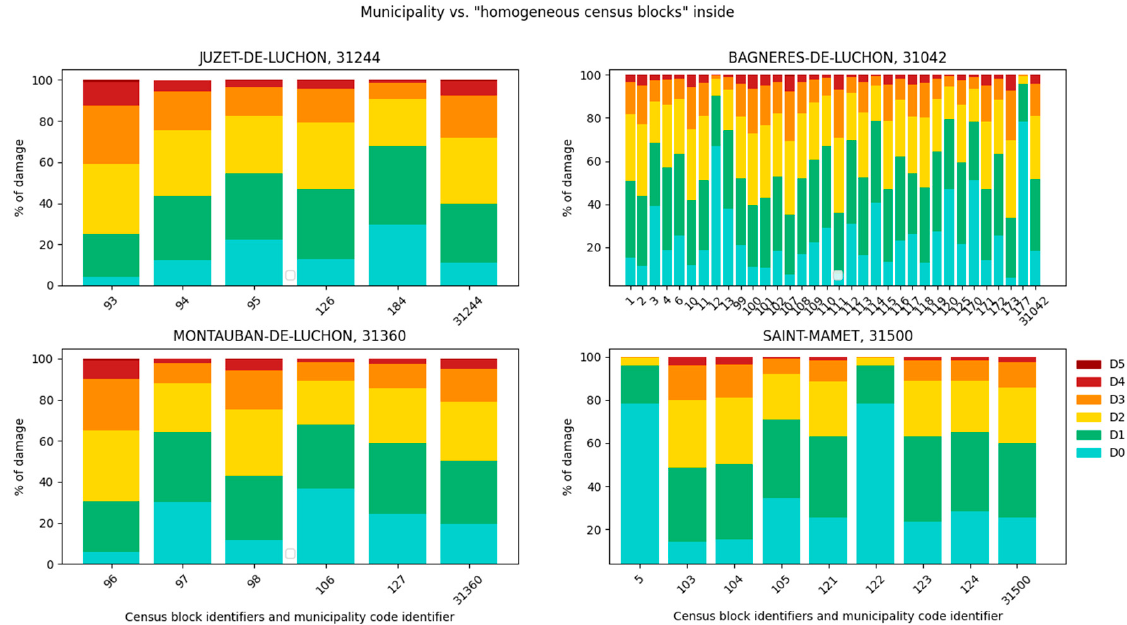
Figure 7. The damage distribution per municipality (last bar chart of each graphic) and per corresponding homogeneous vulnerability census blocks inside each municipality.